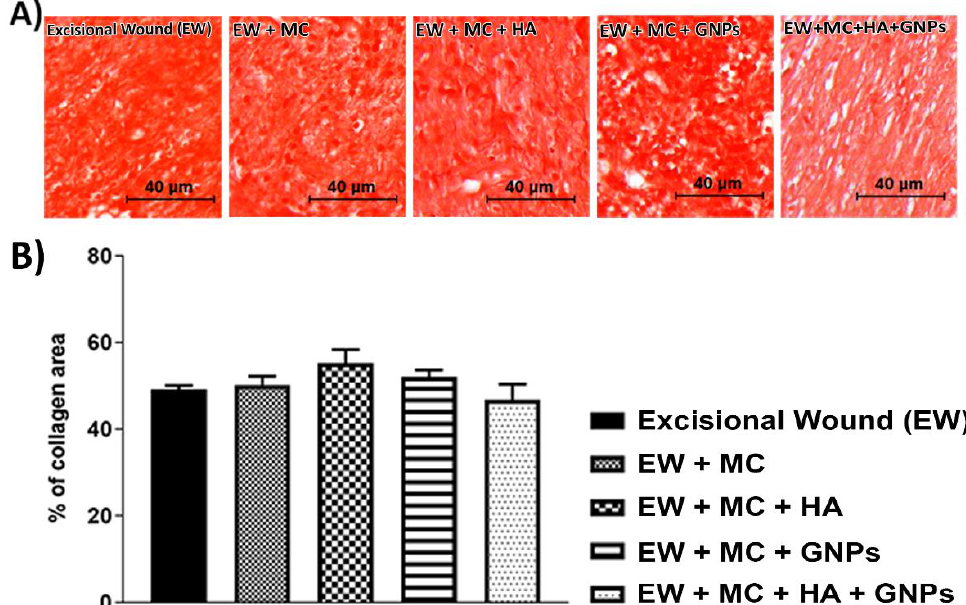
Figure 4. ( A ) Representative images of the histological sections of the integumentary system. ( B ) Effects of treatment with MC, GNPs, and hyaluronic acid on the % of collagen area. The data are presented in mean ± EPM, (EW; one-way ANOVA followed by Tukey’s post hoc test).